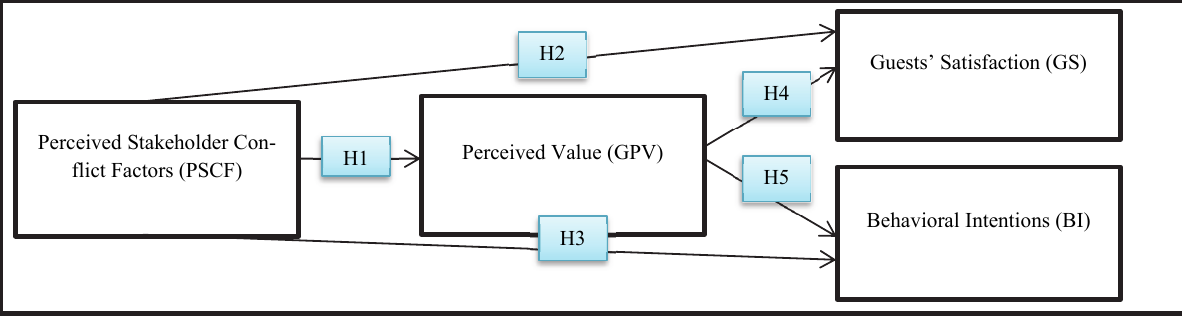
Fig. 1. Research Conceptual